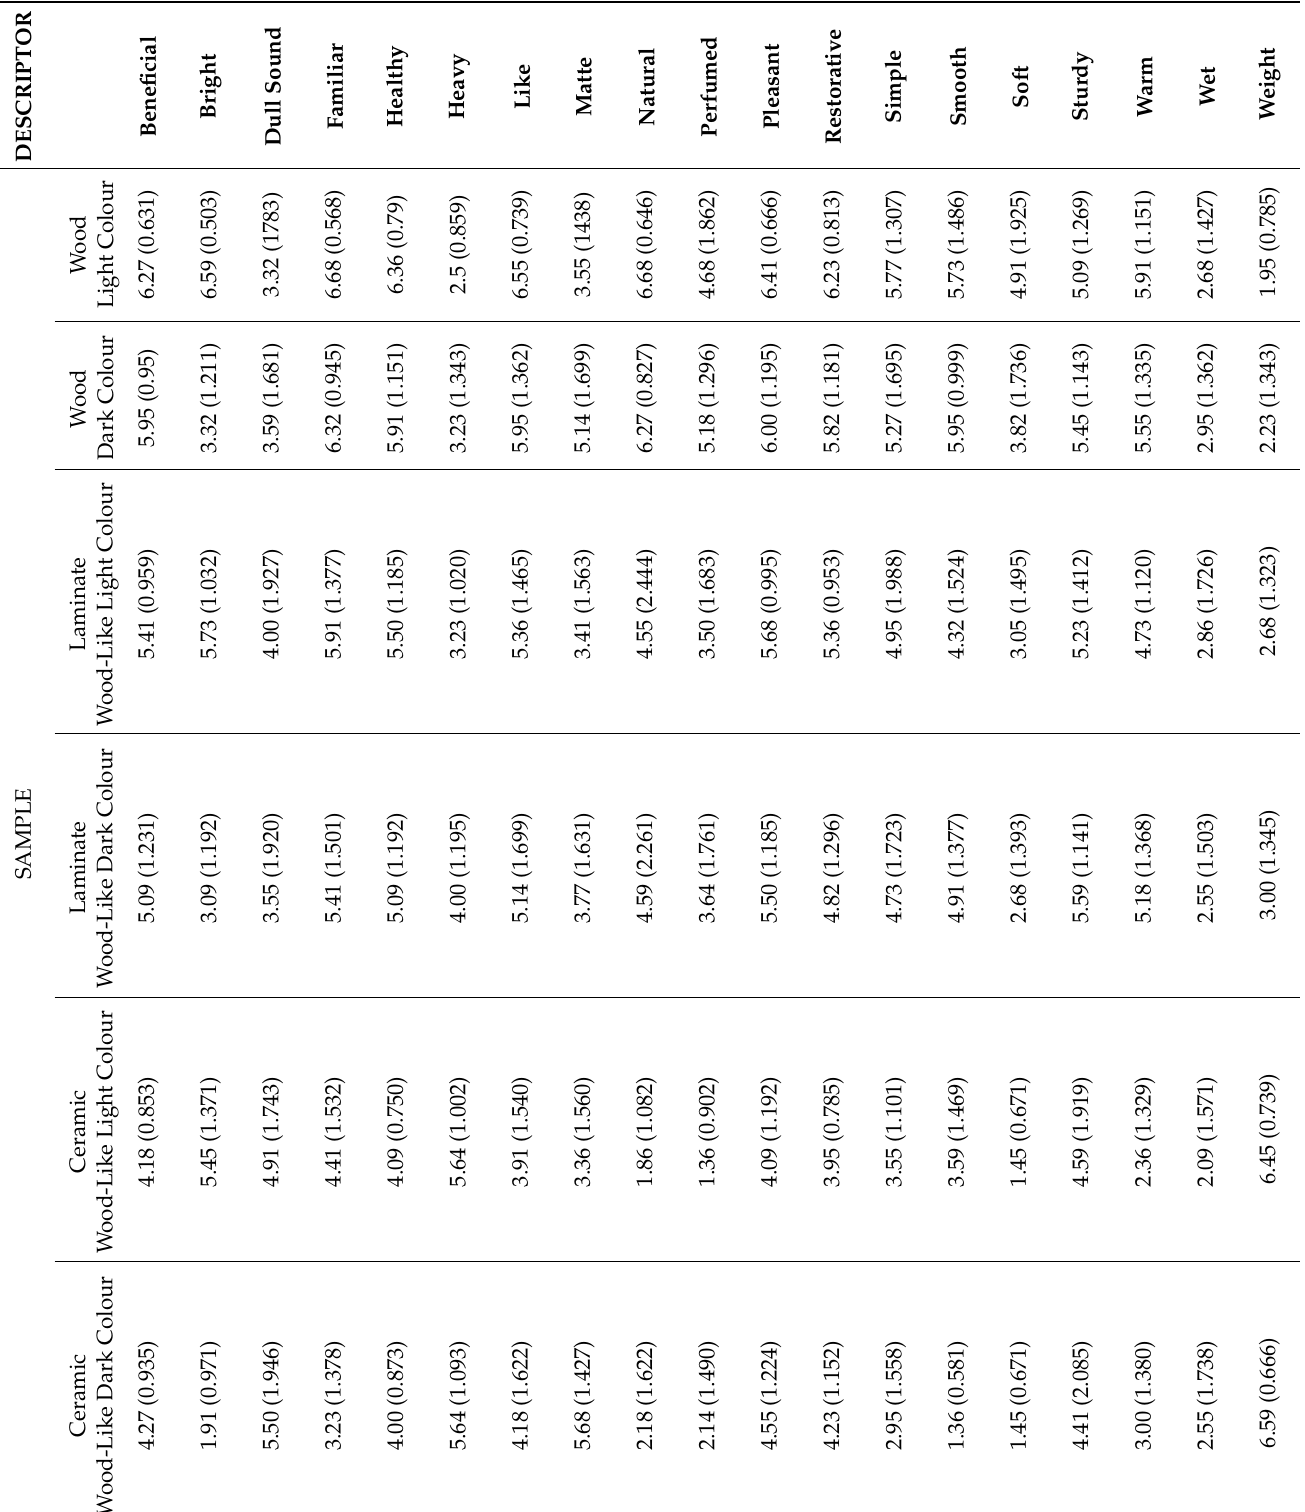
Table 2. Mean description ( ± standard deviation) of the different samples as a function of